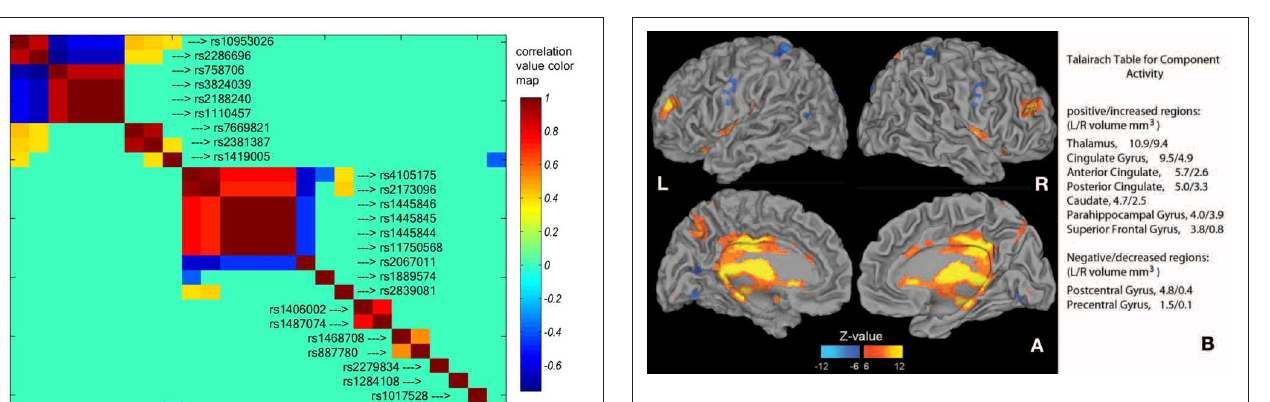
FIGURE 3 | The fMRI component linked to the SNP component. (A) Activation map with | z | value > 6 while responding to target vs. standard stimuli in the auditory oddball task. Red to yellow color indicates positive activation regions, while blue indicates deactivation regions. (B) A list of regions and volumes with | z | value > 6. The activation regions mainly include thalamus, anterior cingulate and posterior cingulate gyri and deactivation regions are mainly in left pre- and post-central gyri. Note that the pre- and post-central gyri are mainly positively activated during the task, and the deactivation in this component is only fraction of activation that covaries with positive activation in thalamus, cingulate gyrus, etc.